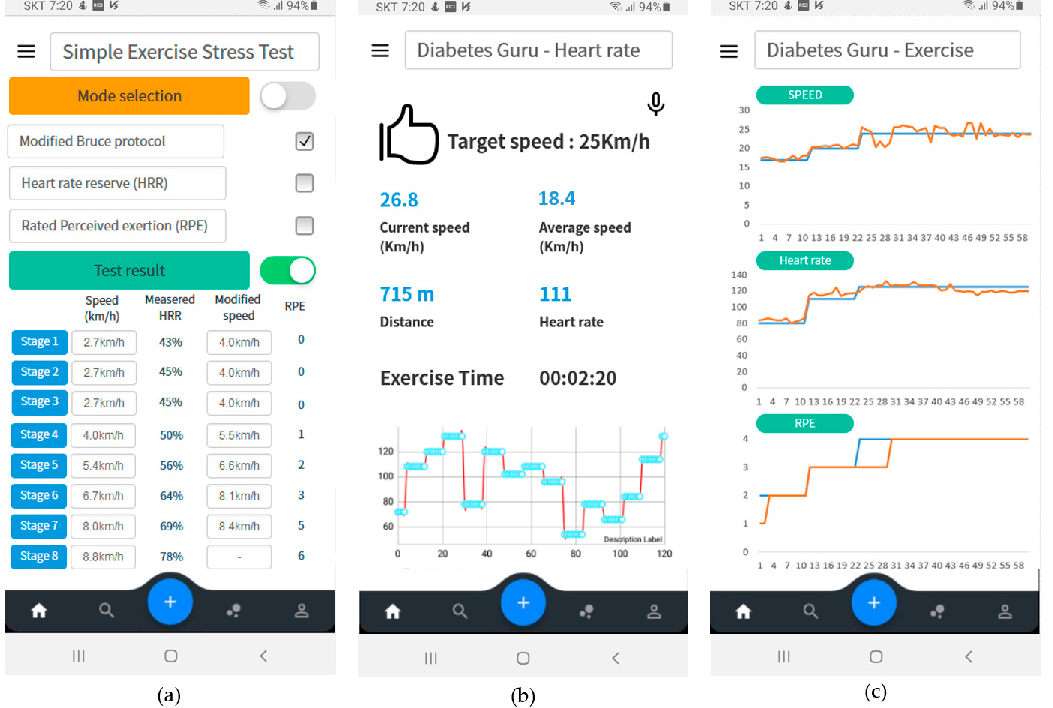
Figure 12. User interface configuration of proposed therapeutic exercise application; ( a ) Results of simple exercise stress test, ( b ) real-time monitoring based on heart rate, ( c ) exercise summary after exercise finish.